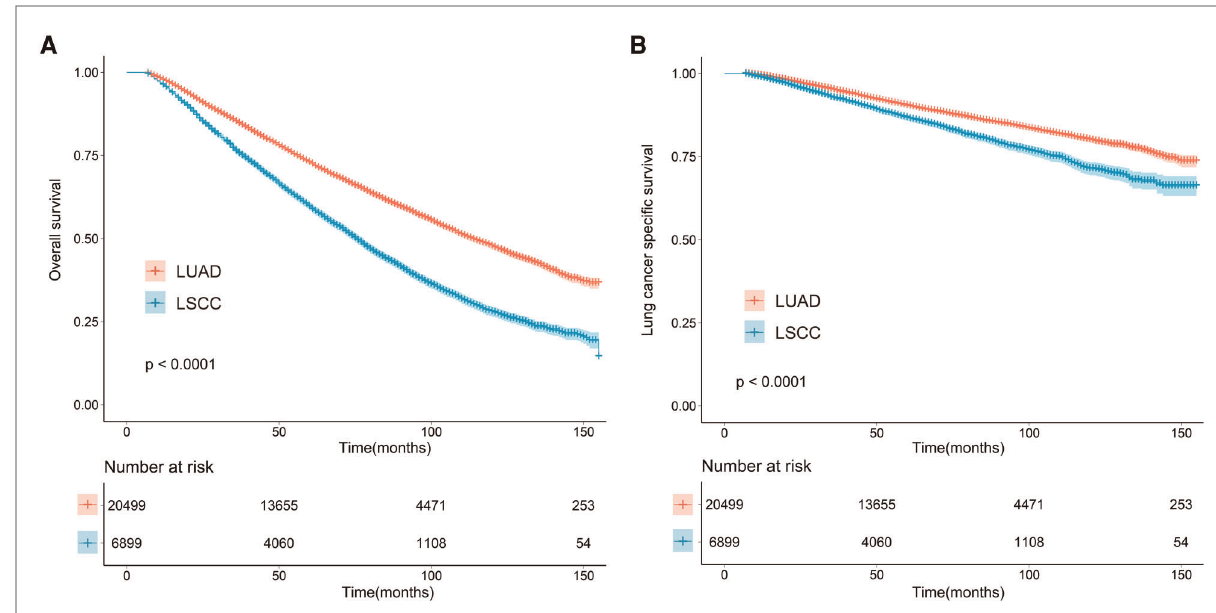
FIGURE 1 Overall ( A ) and lung cancer – speci fi c survival ( B ) for lung cancer patients with adenocarcinoma and squamous cell carcinoma before matching. LUAD, lung adenocarcinoma; LSQCC, lung squamous cell